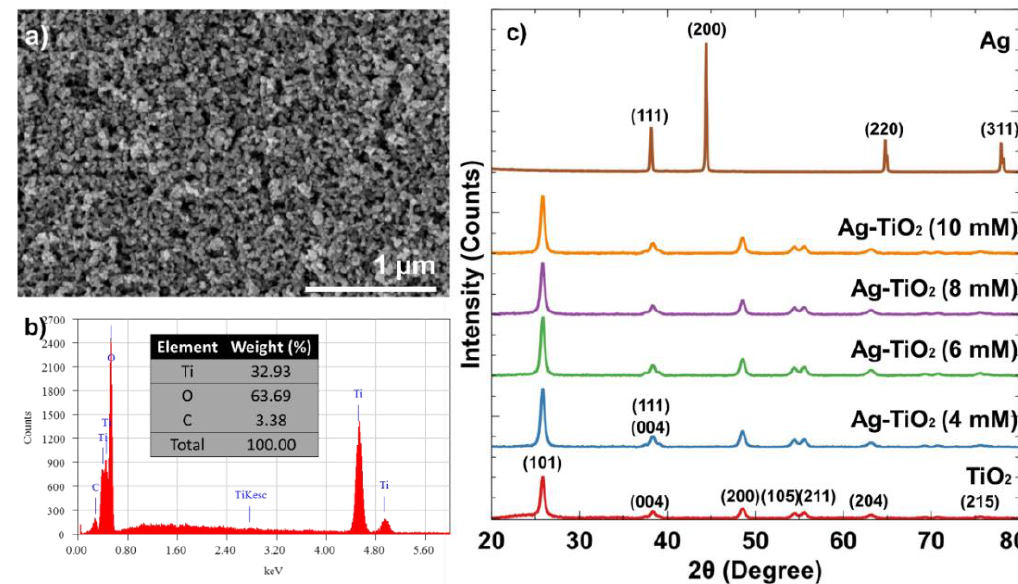
Figure 6. ( a ) FESEM image, ( b ) EDS spectrum of TiO 2 film and ( c ) X-ray diffraction (XRD) pattern for AgNP, anatase TiO 2 and Ag-TiO 2 nanopowder at different of AgNP sizes.